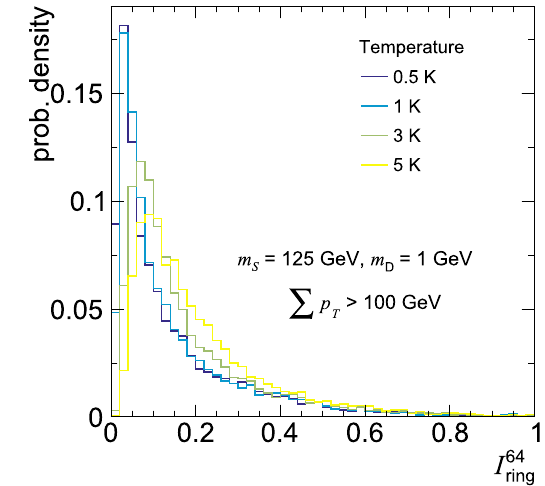
p T > 0 . 1 GeV and | η | < 2 . 4. Only events that pass the requirement (cid:17) p T > 100 GeV are kept. The production mode is Gluon Fusion (GF) with a dark photon branching fraction of BR ( A (cid:7) γ → ee ,μμ,ππ) =